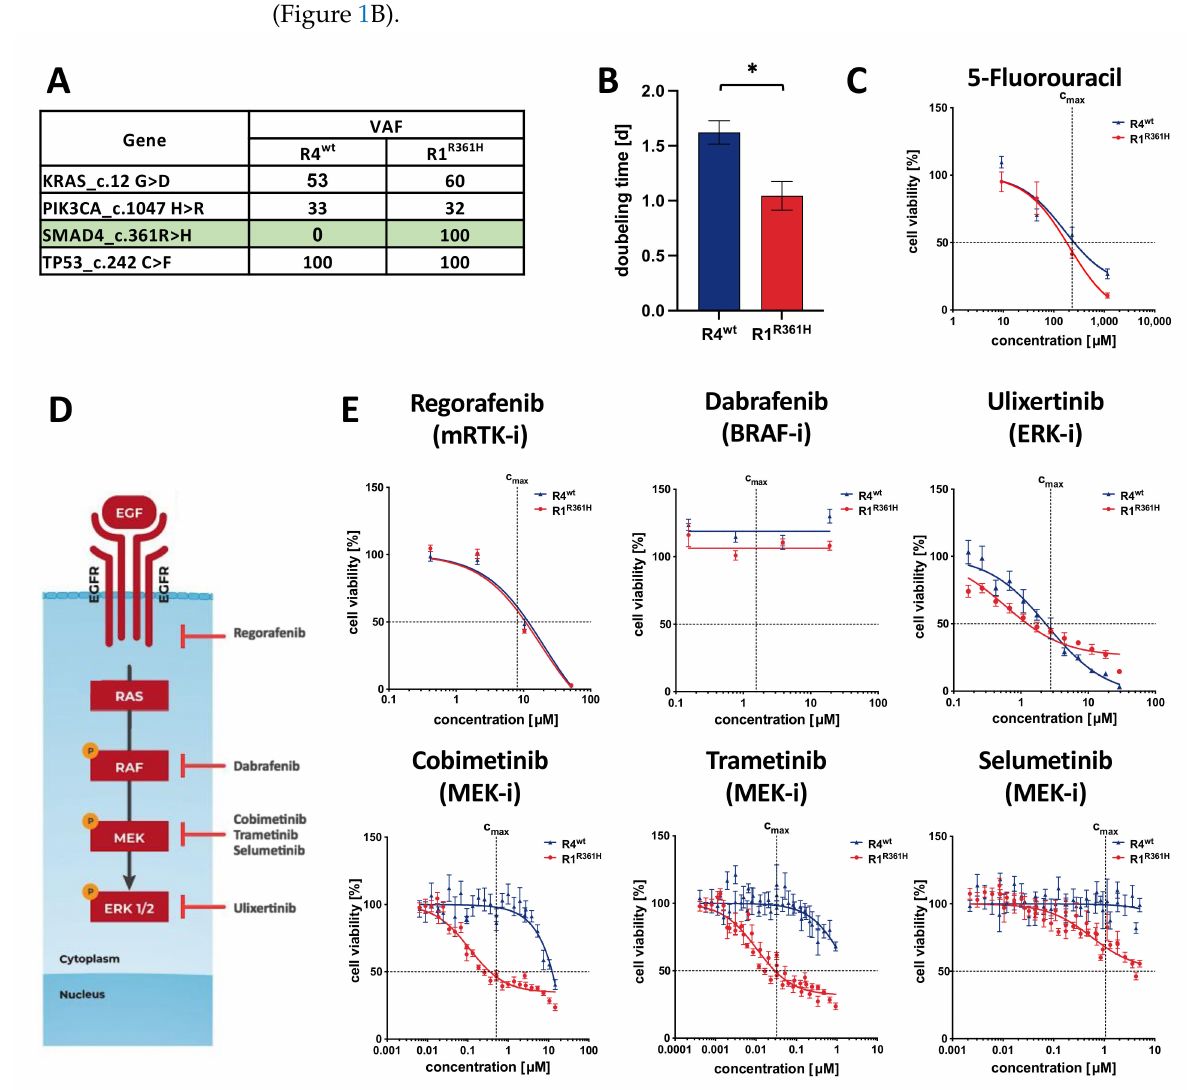
Figure 1. Single gene alteration leads to differential drug responses. ( A ) CRC-Panel DNA Sequenc- ing of two representative sibling PDOs differing in SMAD4 mutational status (R4 wt and R1 R361H ) (Variant allele frequencies (VAF) are shown). ( B ) Doubling times of R4 wt and R1 R361H . The cell density was measured on day 2, 3, 5, and 7 by measuring cellular ATP content using Cell Titer Glo ® assay. Results from four independent experiments were combined (one-way ANOVA * p < 0.05). ( C ) Drug response curves of R4 wt and R1 R361H treated with 5-Fluorouracil (5-FU). ( D ) Scheme of the MAPK signaling pathway with interruption of signal transduction due to small molecules (mRTK-inhibitor: regorafenib, BRAF -inhibitor: dabrafenib, MEK-inhibitors: cobimetinib, trametinib, selumetinib, and ERK-inhibitor: ulixertinib). ( E ) Drug response curves of R4 wt and R1 R361H treated daily for 4 days with small molecules targeting the MAPK signaling pathway. Cell sensitivity in three biological and four technical replicates was defined according to IC 50 values in relation to the maximal plasma concentrations (c max ), which are indicated for each drug with dotted lines. In all panels: Nonlinear curve fit, comparison of best-fit values, extra sum-of-squares F Test p < 0.05. (See also Figure